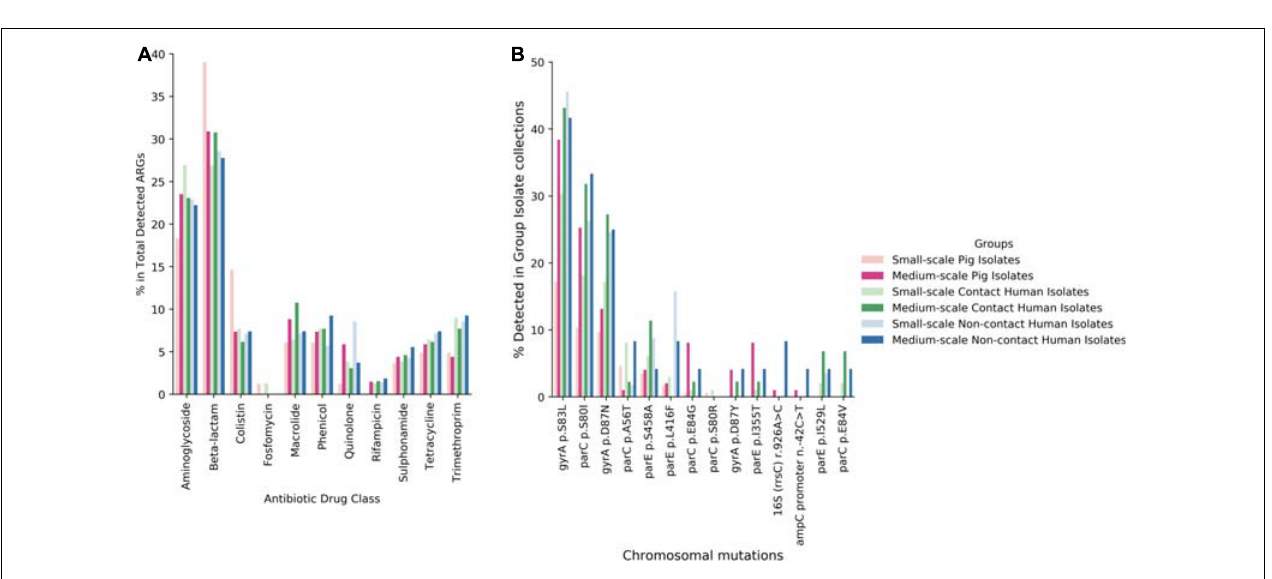
FIGURE 4 | Overview of total ARGs and chromosomal mutations. (A) Display of % of total ARGs according to antibiotic drug class for each investigation group of this study. (B) Display of % of antibiotic resistant associated chromosomal for each investigation group of this